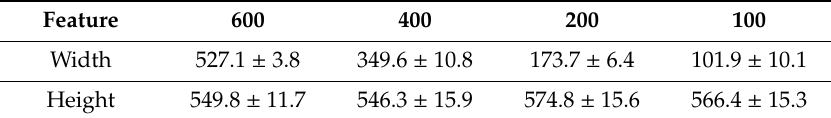
Table 1. Dimensions of printed micro feature (unit: µ m).